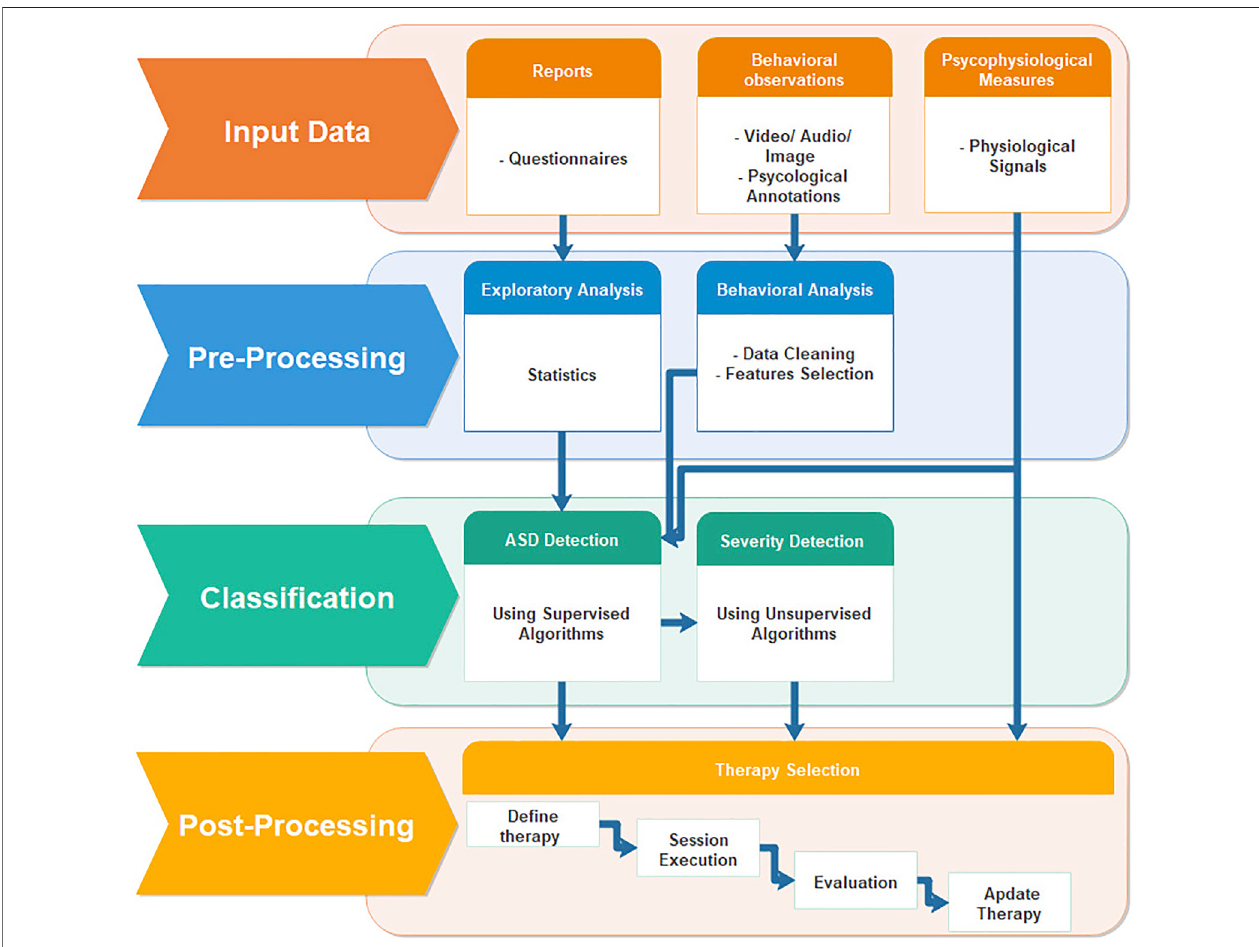
FIGURE 7 | Input, outputs, and processing levels used by the robot therapist ’ s